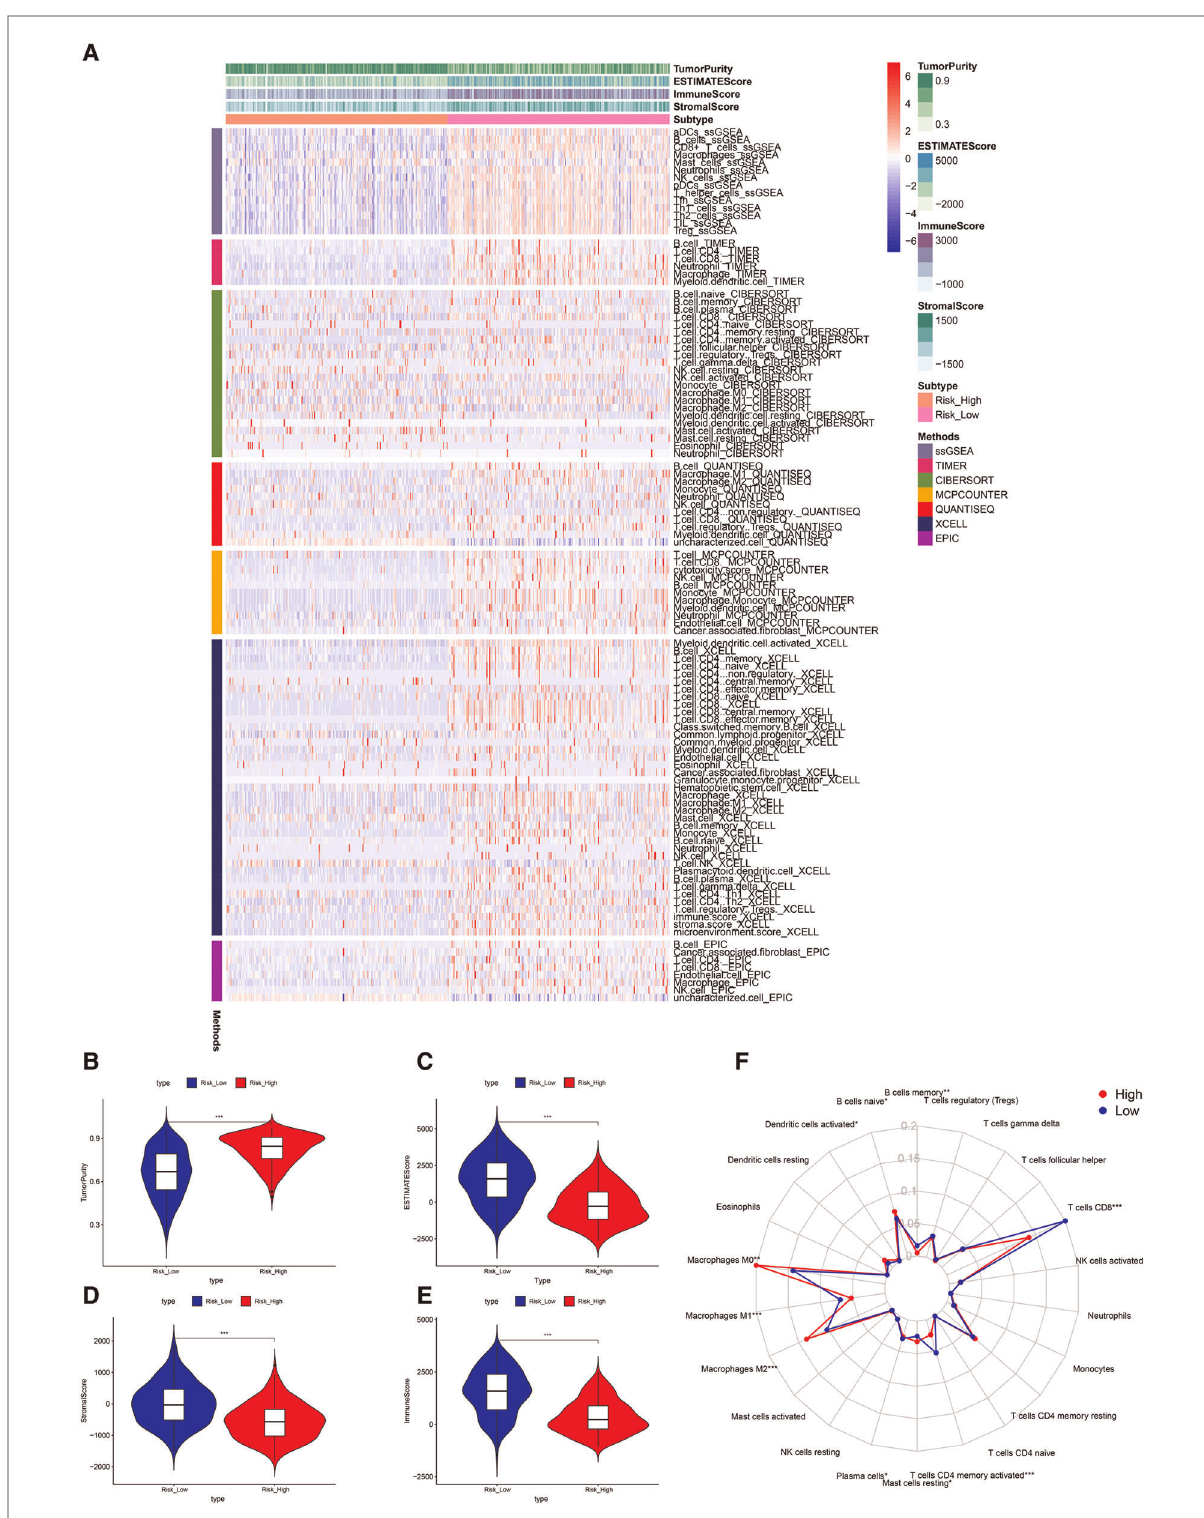
FIGURE 6 Tumor microenvironment analyses. ( A ) Immunity heatmap including the Tumor purity score, ESTIMATE score, immune score, stromal score and 7 other algorithms (ssGSEA, TIMER, CIBERSORT, MCPcounter, QUANTISEQ, XCELL, and EPIC). ( B ) The high-risk group had signi fi cantly higher tumor purity. ( C – E ) The high-risk group had signi fi cantly lower ESTIMATE, stromal, and immune scores. ( F ) A radar plot shows that the high-risk group had signi fi cantly fewer CD8+ T cells, CD4+ memory activated T cells and M1 macrophages, but more M0 and M2 macrophages. * P <0.05; ** P <0.01; *** P